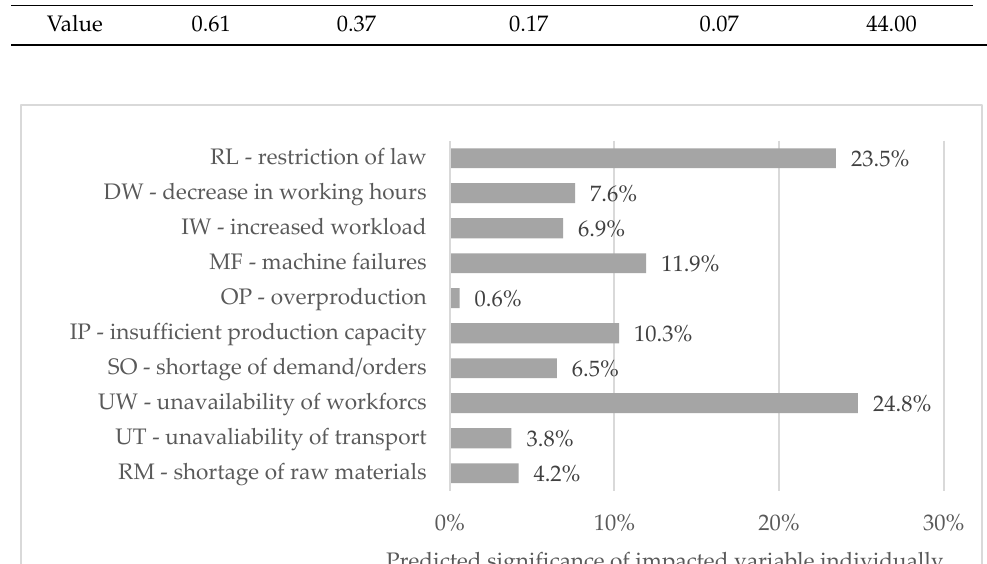
Figure 6. Predicted significance of impacted variables.